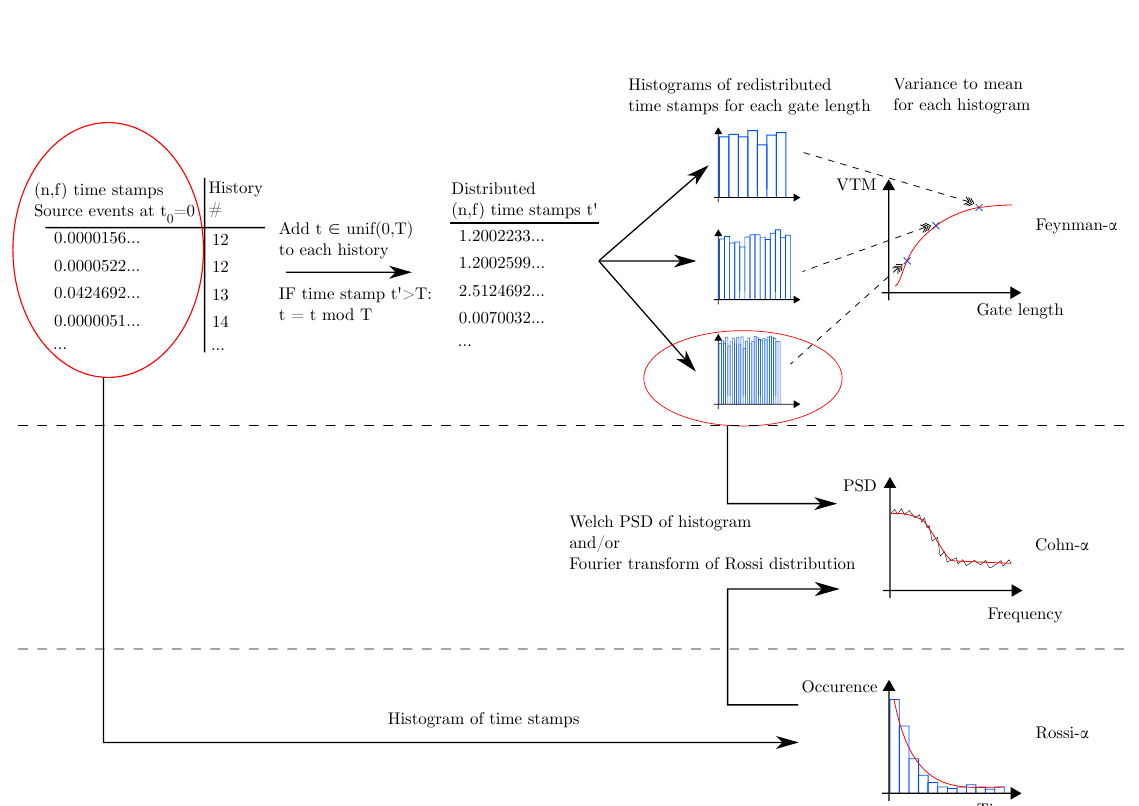
Figure 2: Illustration of how to treat time stamp data from MC simulations to create the observable noise data allowing for curve fitting with the Rossi, Feynman or PSD expressions.